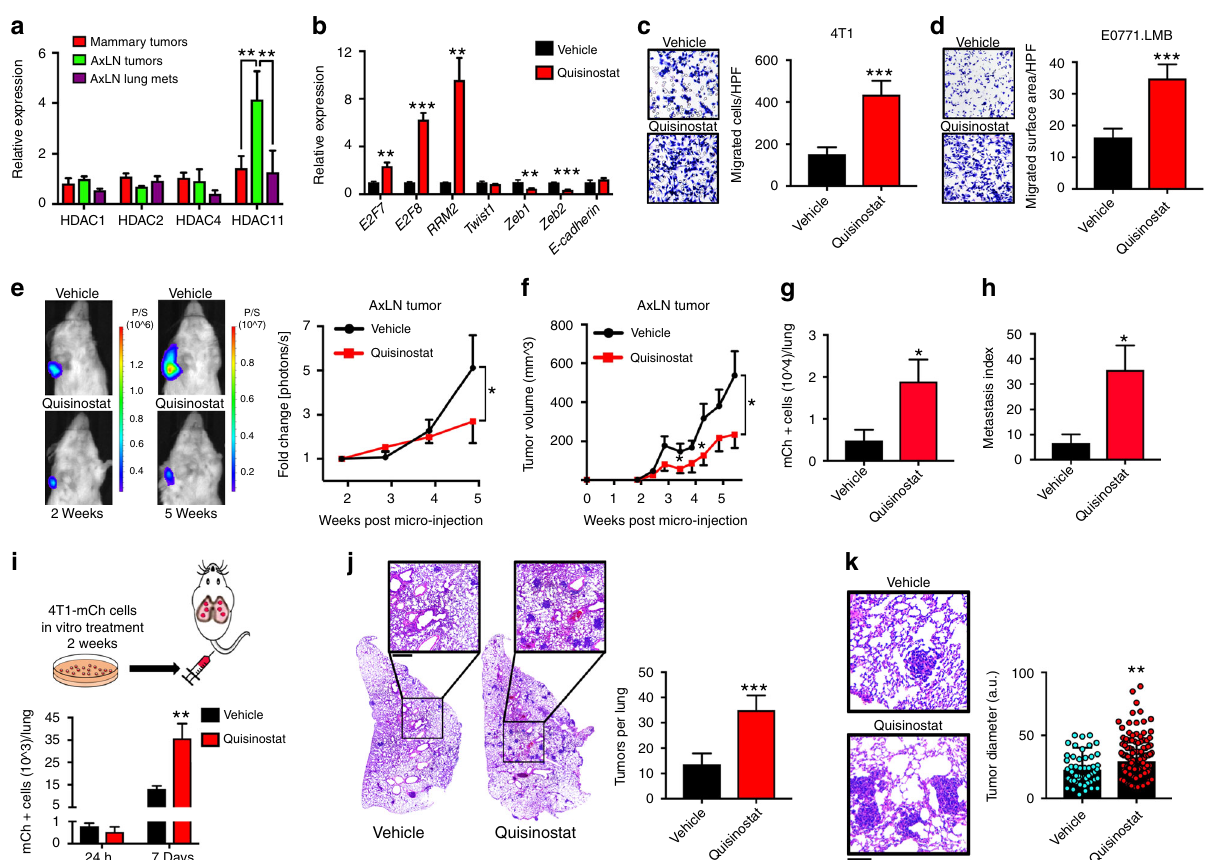
Fig. 5 Pharmacological HDAC inhibition reduces cell and tumor growth, but increases cell migration and tumor metastasis from LNs. a HDAC mRNA expression levels from ex vivo 4T1 clones. b Target gene E2F7 , E2F8 , and RRM2 and EMT marker expression levels after quisinostat treatment. c , d , Transwell migration assay for 4T1 ( c ) and E0771-LMB ( d ) TNBC cells. e Intravital imaging of LN tumors of mice implanted with 4T1-mCh/rL cells. f Tumor volumes for LN-micro-injected tumor-bearing mice treated with vehicle or quisinostat (40 mg/kg; twice weekly). g Enumeration of lung micro- metastases in LN-micro-injected tumor-bearing mice after 6 weeks. h Metastasis index of vehicle- and quisinostat-treated mice after normalization to LN tumor size ( n = 10 mice/group for f – h ). i Enumeration of lung micro-metastases after in vitro-treated vehicle or quisinostat 4T1-mCh/rL cells were injected by the tail vein. j H&E staining of stitched left lungs from tail vein-injected mice. The graph shows the average number of tumors per lung for vehicle- and quisinostat-treated mice. k Representative H&E-stained images of lung lesions from vehicle- and quisinostat-treated mice. The graph shows individual tumor diameter measurements. Statistical signi fi cance was measured by unpaired one-sided Student ’ s t tests, unless otherwise indicated; p values are indicated as * p < 0.05, ** p < 0.01, and *** p < 0.001